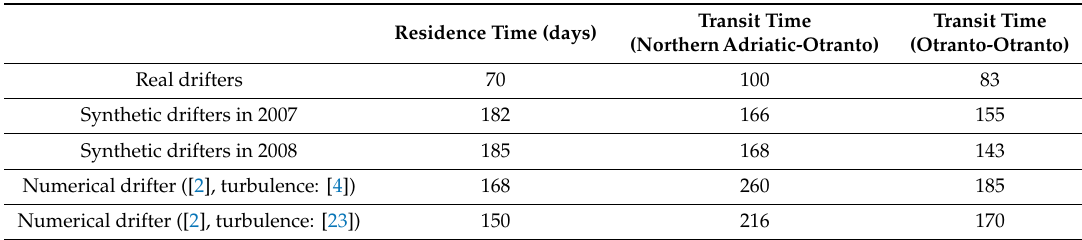
Table 1. Comparison between the Lagrangian parameters